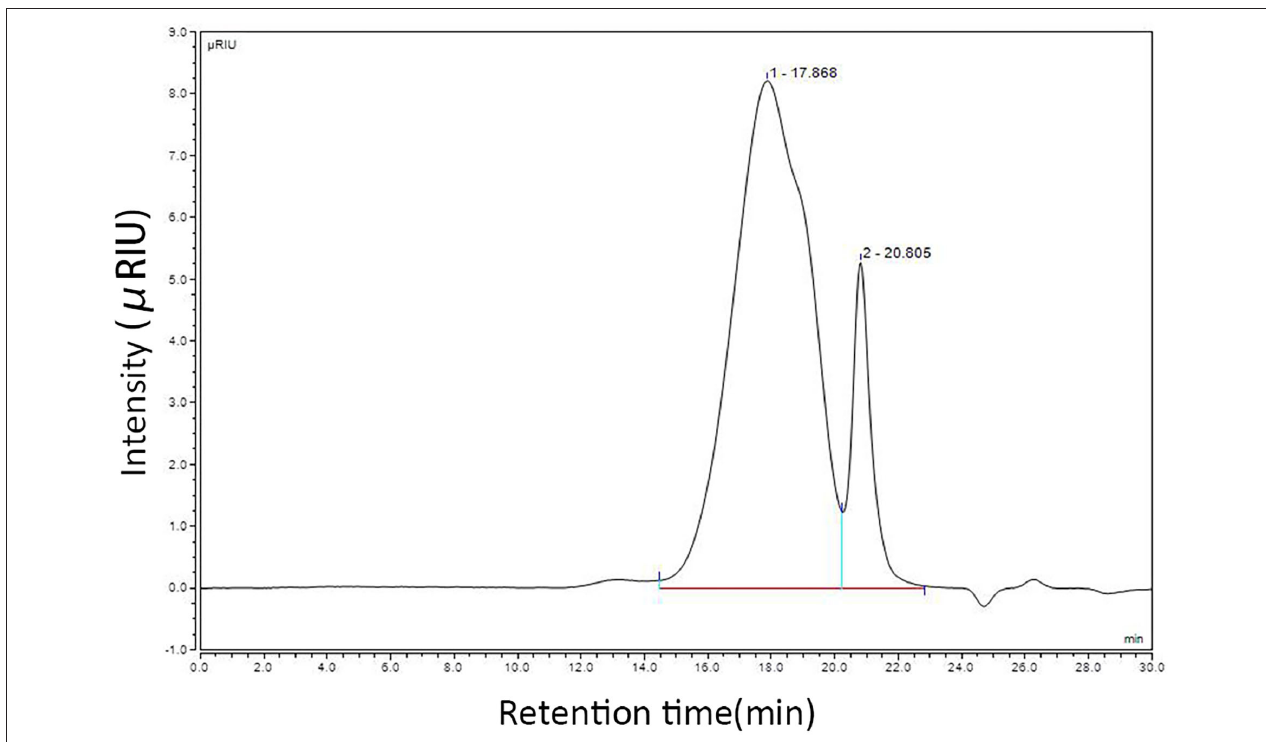
FIGURE 1 | Molecular weight detection results of CSP.